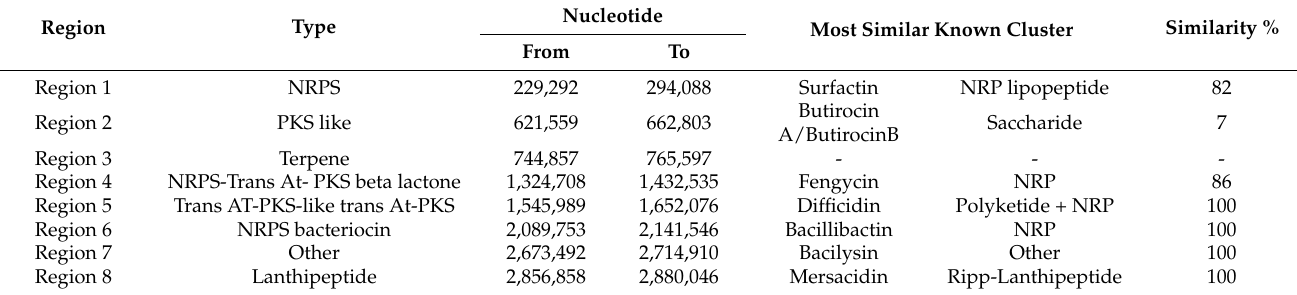
Table 2. Regions Coding for Secondary Metabolites in the Genome of Bacillus velezensis